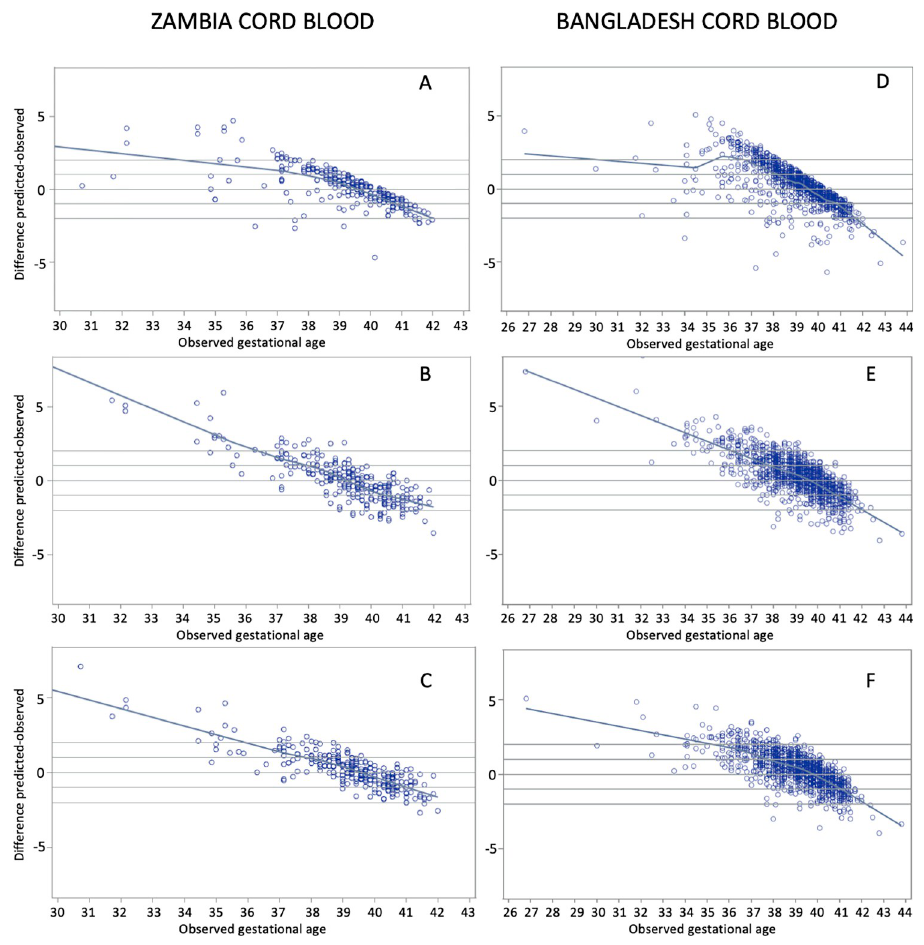
Fig 4. Residual plots of predicted–observed by ultrasound-assigned gestational age. Cord blood samples from Zambia: (A) Model 1: Baseline Model, (B) Model 2: Analyte Model, and (C) Model 3: Full Model. Cord blood samples from Bangladesh: (D) Model 1: Baseline Model, (E) Model 2: Analyte Model, and (F) Model 3: Full Model.